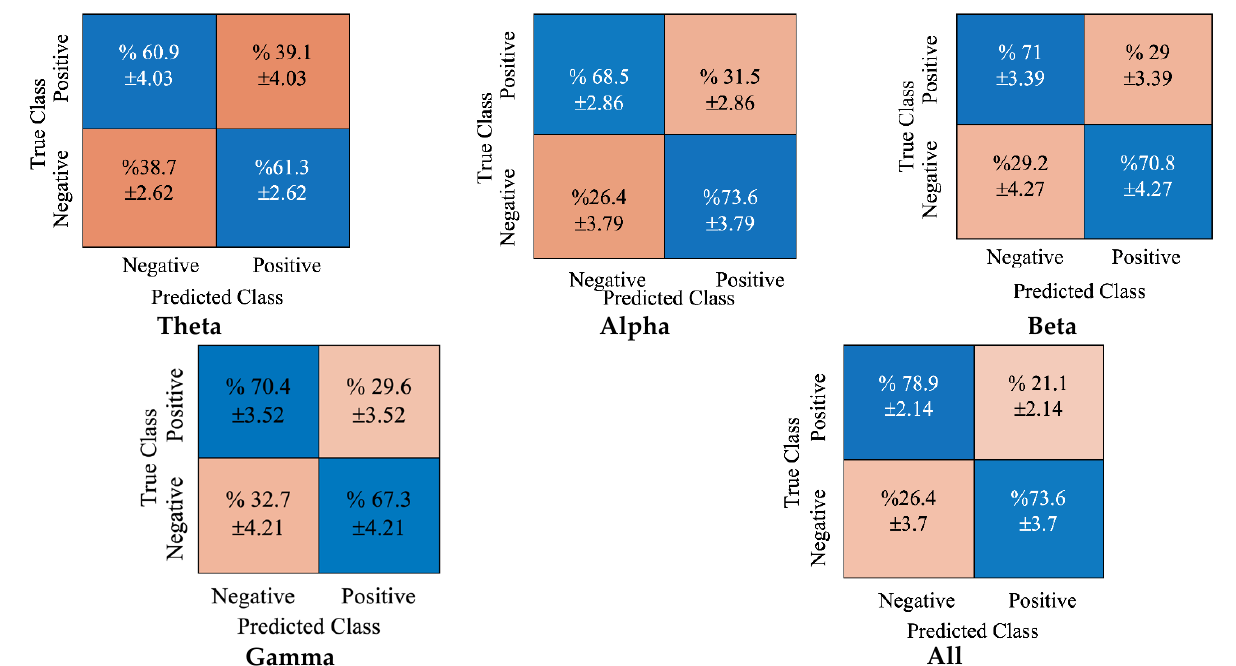
Figure 5. The obtained confusion matrices for DE features and SVM classifier. In Figure 6, the obtained cumulative confusion matrices for each rhythm and concatenated all rhythms for the kNN classifier are provided. As the gamma rhythm produced the best achievement for the kNN classifier, its cumulative confusion matrices were observed, and the true classification accuracies for positive and negative classes were 74.5% and 73.5%, respectively. Conversely, the false positive and negative accuracy scores were 25.5% and 26.5%, respectively.